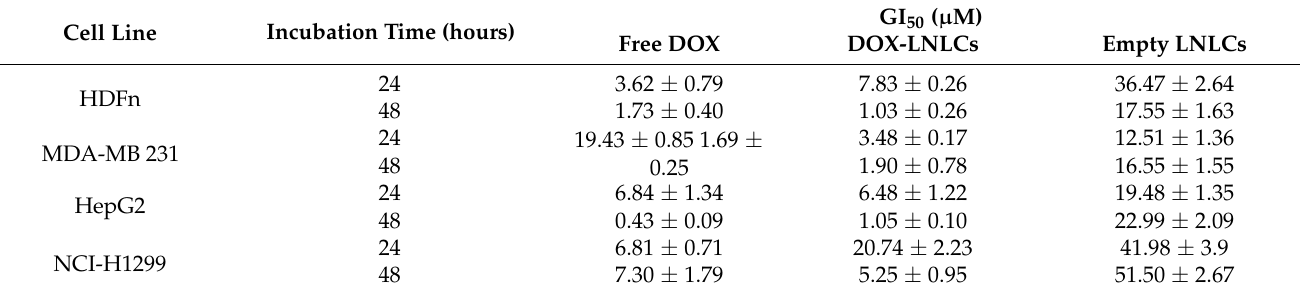
Table 1. GI 50 values and respective deviation standard (SD) of three independent experiments for free DOX, DOX-LNLCs and empty LNLCs as a function of cell lines and incubation time.